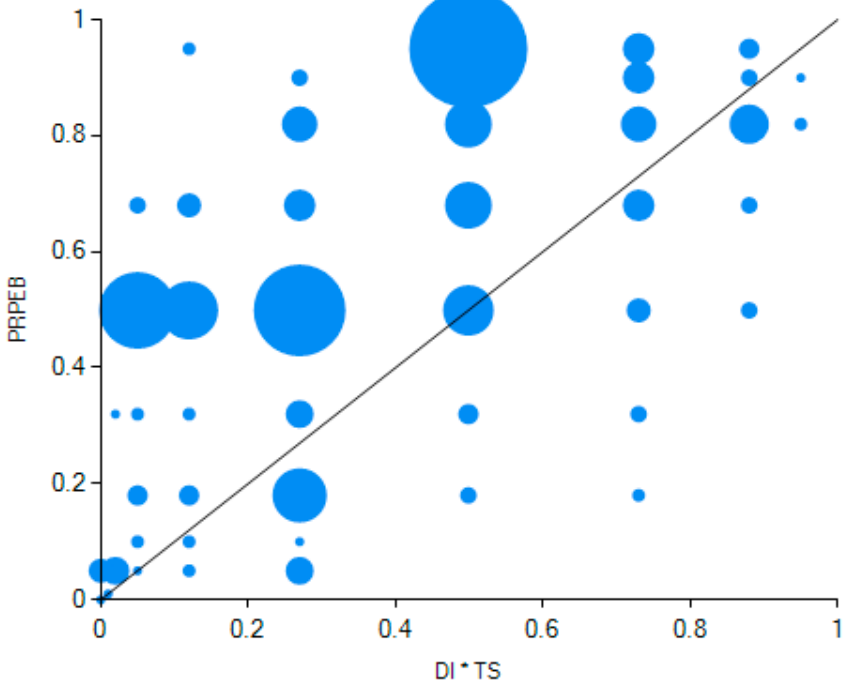
Figure 2. Explanation example of configuration 1 in the private pro-environmental behavior mode.